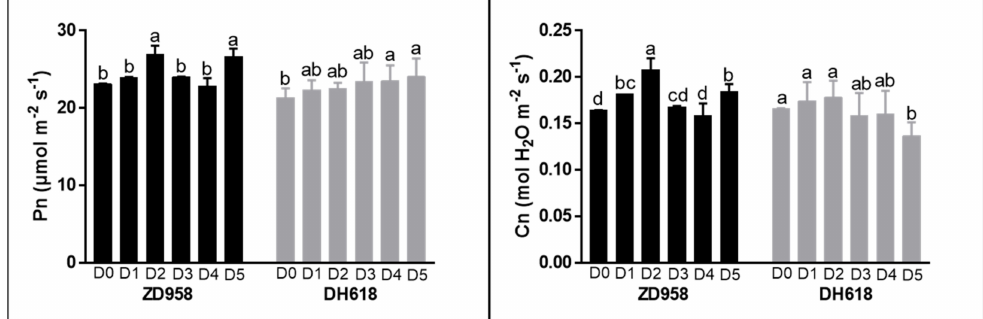
Figure 3. Ear leaf photosynthetic rate (Pn) and stomatal conductance (Cn) at the grain filling stage of maize cultivars ZD958 and DH618 after six leaf removal treatments in 2018. Di ff erent lowercase letters of the same cultivar above the columns showed the significant di ff erence between each treatment at P <